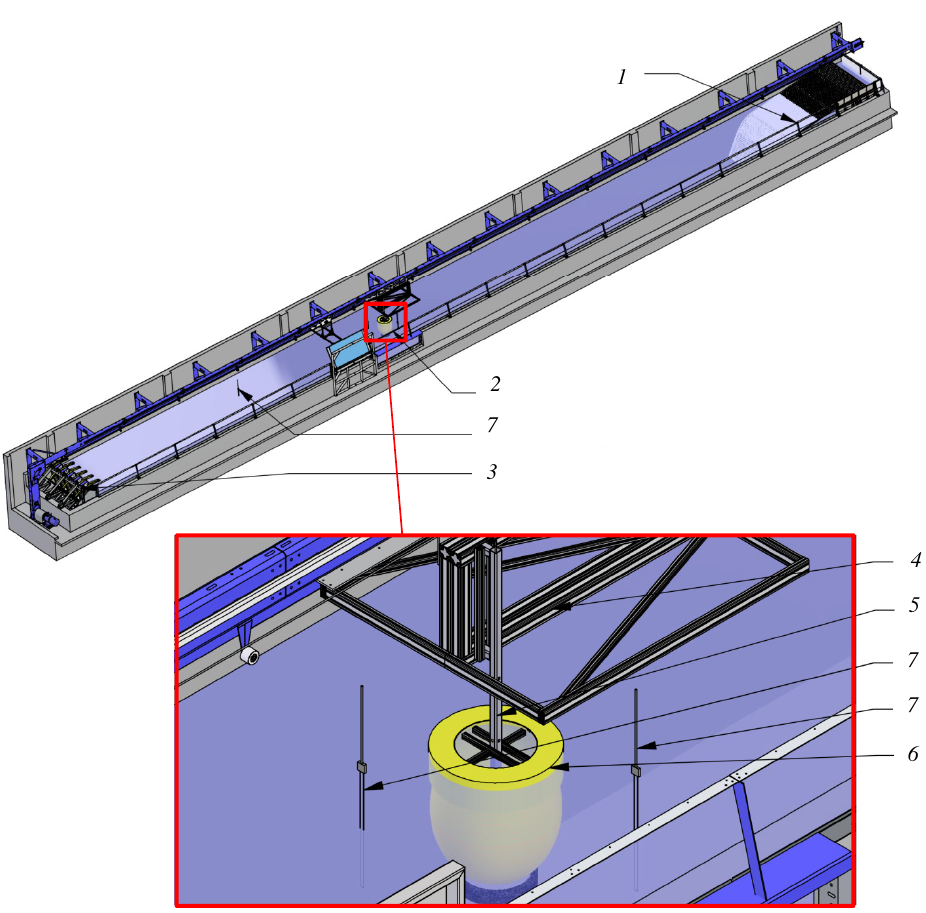
Figure 1. The experimental setup: 1—wave absorber, 2—tested model on carriage, 3—wave generator, 4—towing carriage, 5—measurement beam, 6—tested model, 7—wave